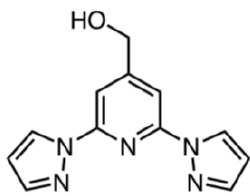
Figure 1. The dppOH (2,6-di(pyrazol-1-yl)-4-(hydroxymethyl)pyridine) ligand.